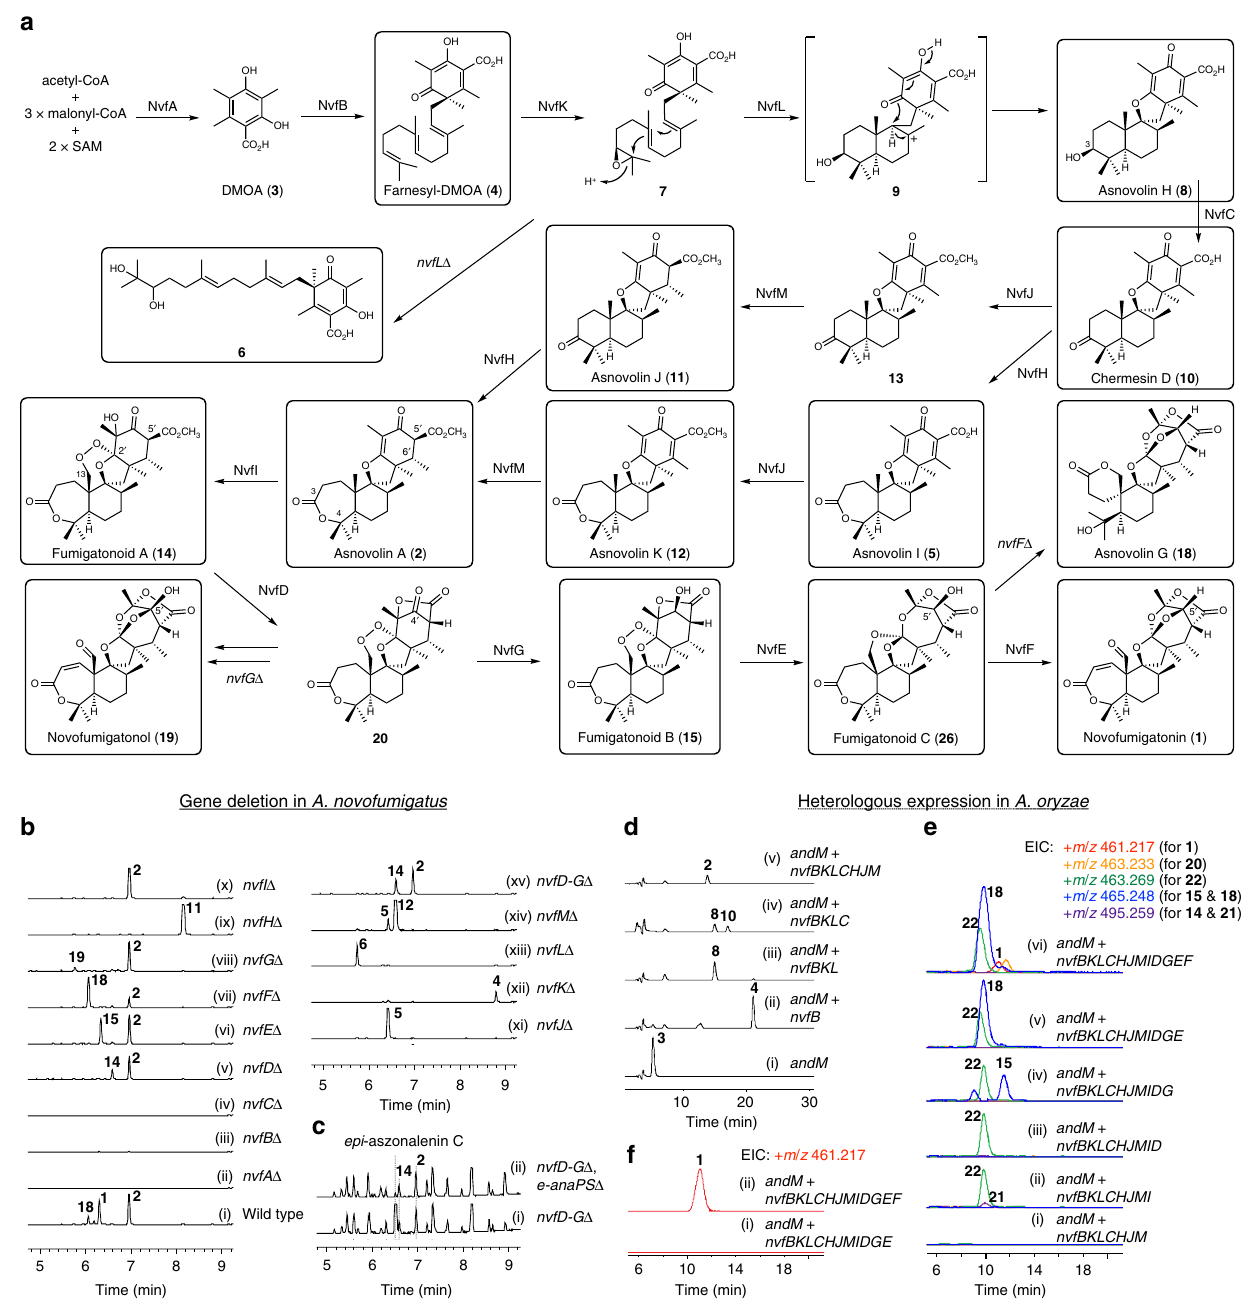
Fig. 2 Biosynthesis of novofumigatonin. a Proposed biosynthetic pathway of novofumigatonin ( 1 ). Boxed compounds were isolated in this study. Detailed procedures for isolation and structural determination of the metabolites are provided in the Supplementary Notes 1 to 18. b LC – MS analysis of metabolites from gene-deletion mutants. Extracted ion chromatograms (EICs) at m / z 423.251 (for 4 ), 431.243 (for 5 ), 431.279 (for 11 ), 445.259 (for 12 ), 447.275 (for 2 ), 457.256 (for 6 ), 461.217 (for 1 ), 465.248 (for 15 and 18 ), 477.212 (for 19 ), and 495.259 (for 14 ), are shown. c LC – MS analysis after the deletion of e- anaPS . Base peak chromatograms are shown. d HPLC analysis of the metabolites from A. oryzae transformants. Chromatograms were monitored at 300 nm. e , f LC – MS analyses of the metabolites from A. oryzae transformants. The structures of compounds 21 and 22 are shown in Fig.